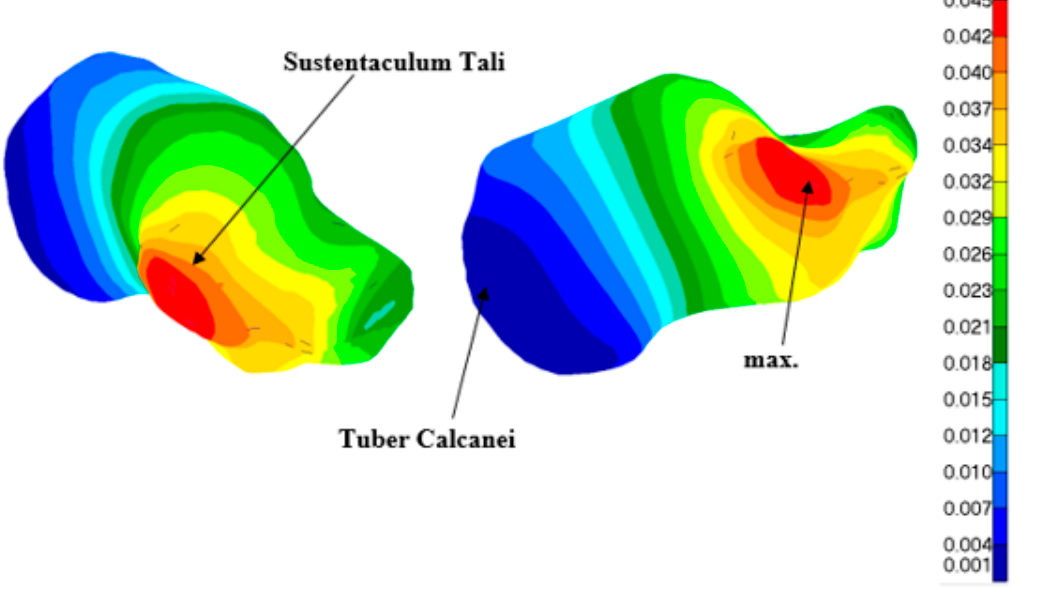
Figure 13. The total displacements on healthy calcaneum created from CT imagery/mm/.